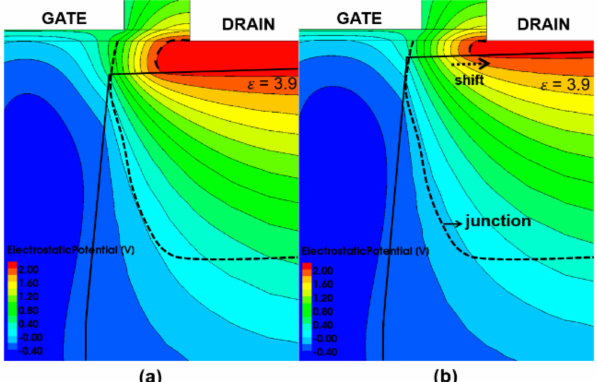
Figure 11. Two-dimensional potential contour profile (at V GS = 0.0 V, V DS = 1.6 V) of the 0.2 step near the drain region in ( a ) PiFET (silicon film thickness = 20 nm) and ( b ) PiFET (silicon film thickness = 10 nm) with slope